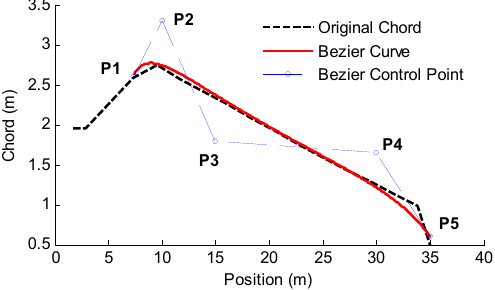
Figure 5. Bezier fitting curve and its control points of the original chord length.